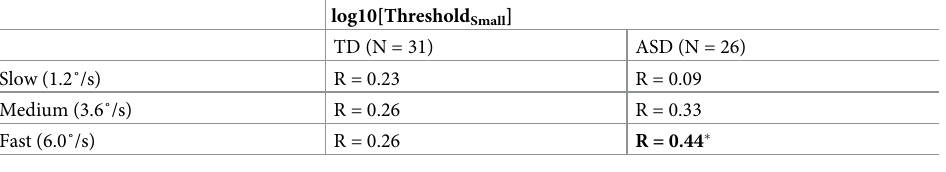
Table 5. Spearman correlations between directional sensitivity to the small moving grating (log10[Threshold- Small ]) and age-corrected gamma response power (GR power ) in TD and ASD